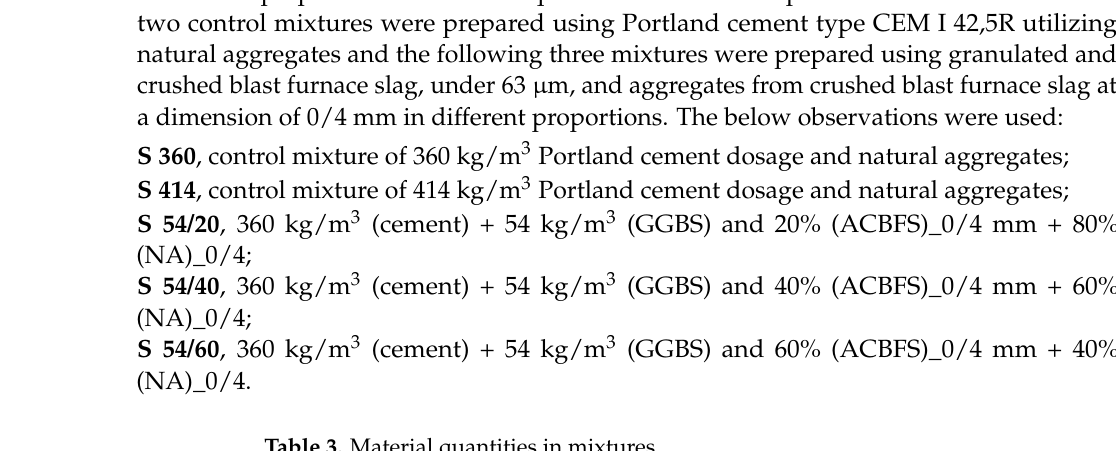
Table 3. Material quantities in